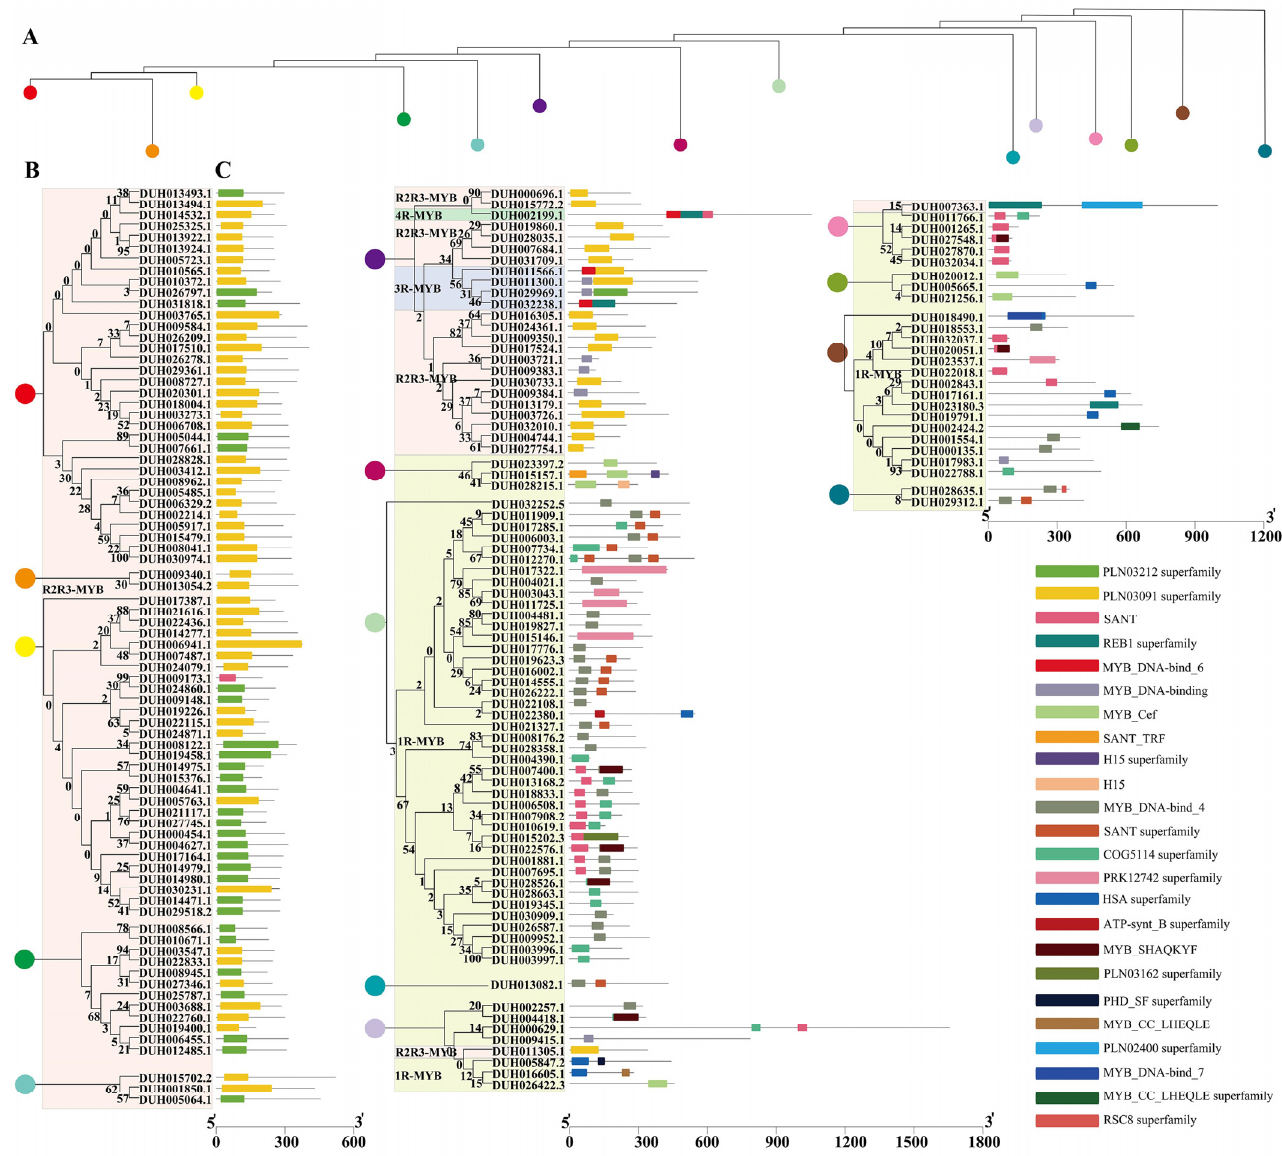
Figure 1. Conserved MYB domain in MYBs of Rhododendron delavayi. ( A ) Phylogenetic tree trunk of 184 R. delavayi MYB genes. It was constructed by maximum likelihood (ML) method based on multiple sequence alignment of 184 amino acid sequences of R. delavayi MYB gene. Different colored circles indicate each node of the phylogenetic tree. ( B ) Branches on each node of the trunk of the phylogenetic tree. The MYB domain was divided into 1R-MYB, R2R3-MYB, 3R-MYB, and 4R-MYB and marked with a colored background. ( C ) Conserved domain composition of these genes. The colored squares indicate the different structural domains.